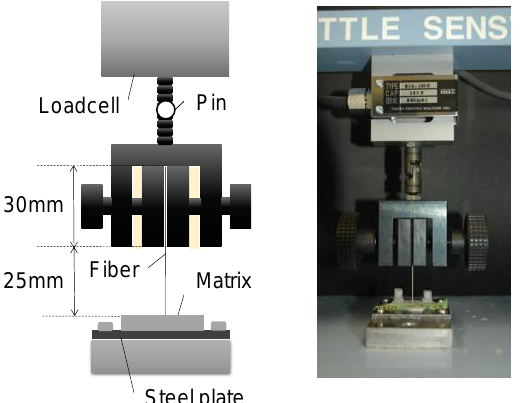
Figure 10. Setup and loading of pullout test.